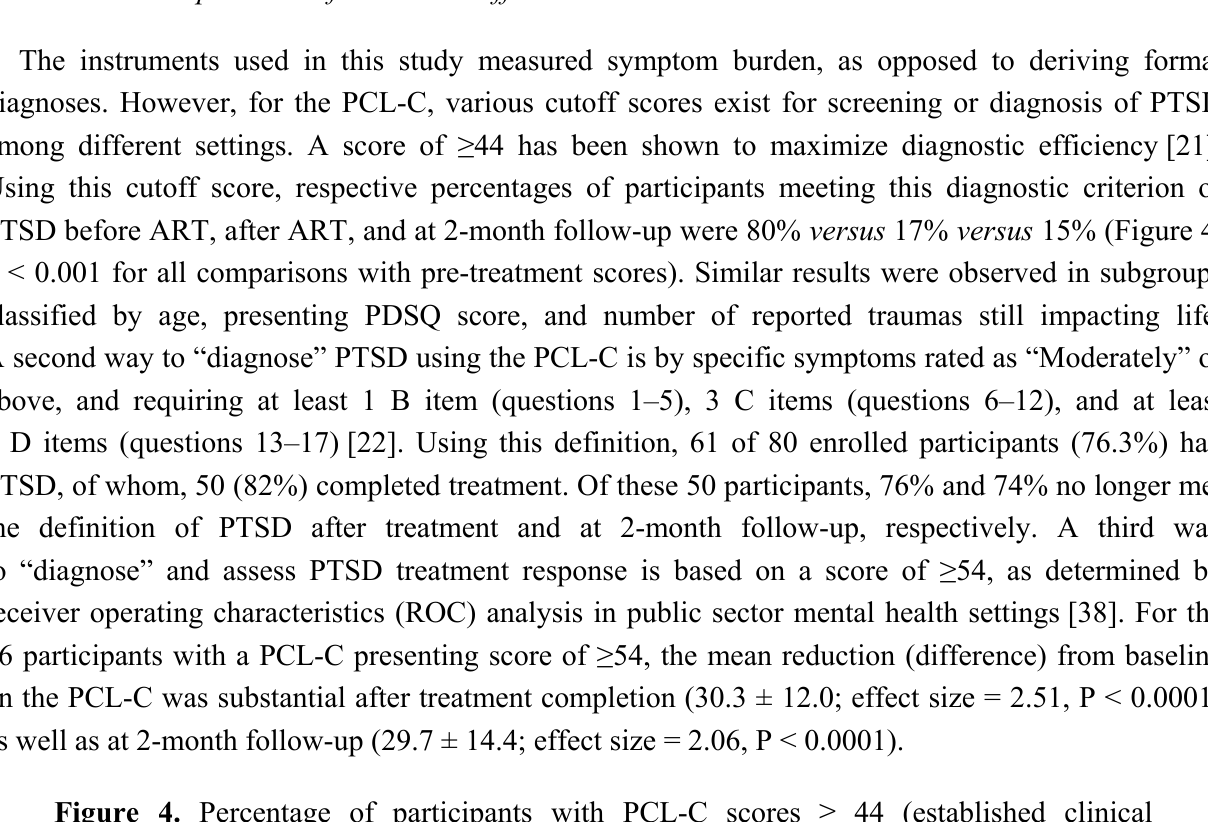
Figure 4. Percentage of participants with PCL-C scores ≥ 44 (established clinical cutpoint) at baseline (minimal shading), post-treatment (moderate shading) and 2-month follow-up (dark